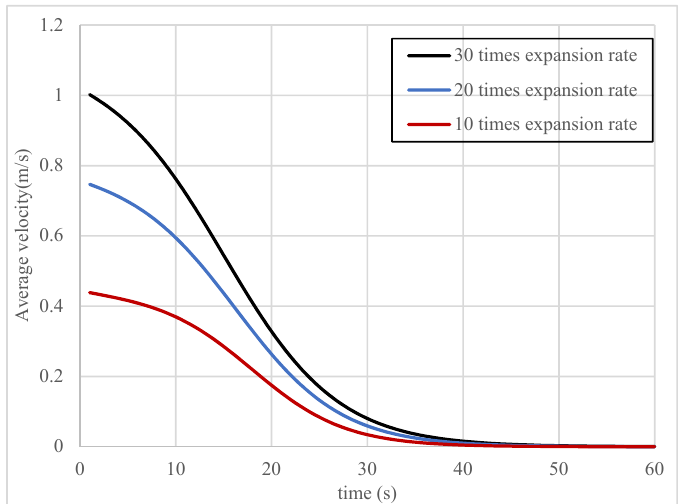
Figure 19. Variation curve of velocity at the interface between slurry and air with time under different grouting amount.